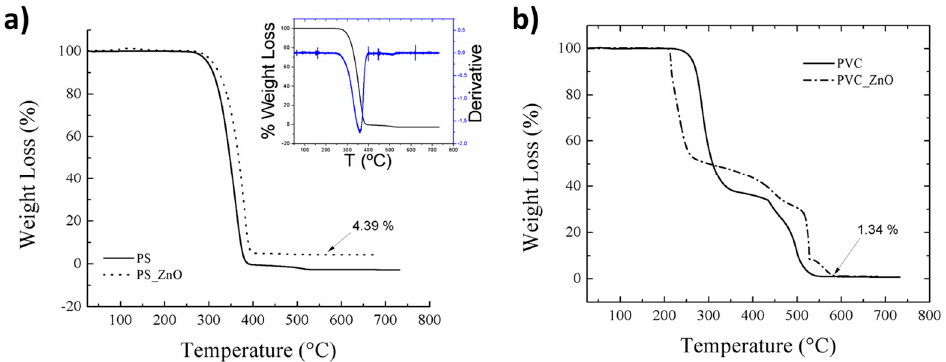
Figure 6. Comparative TGA curves for PS and PS_ZnO samples ( a ); TGA curves for PVC and PVC_ZnO samples ( b ), respectively.